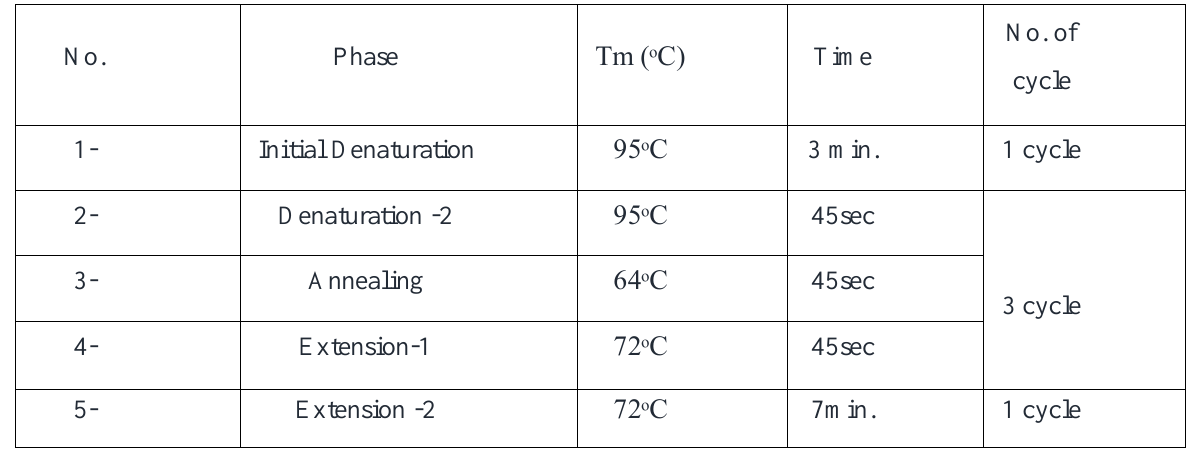
Table 3: The thermal cycle program-specific interaction